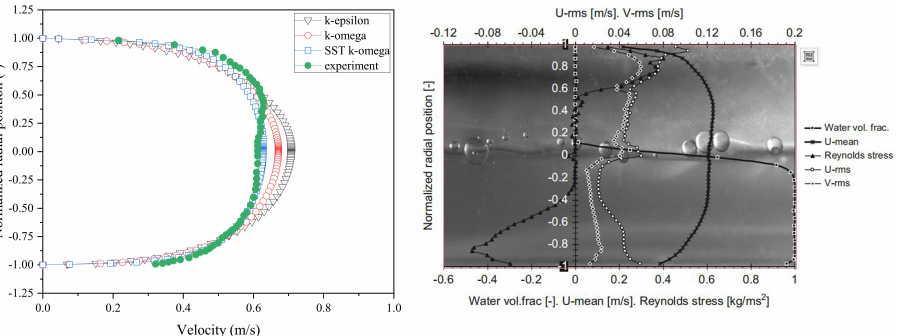
Figure 7. Velocity distribution at pipe centerline under different turbulence models given mixed velocity 0.5 m/s and water cut 0.5 [42].